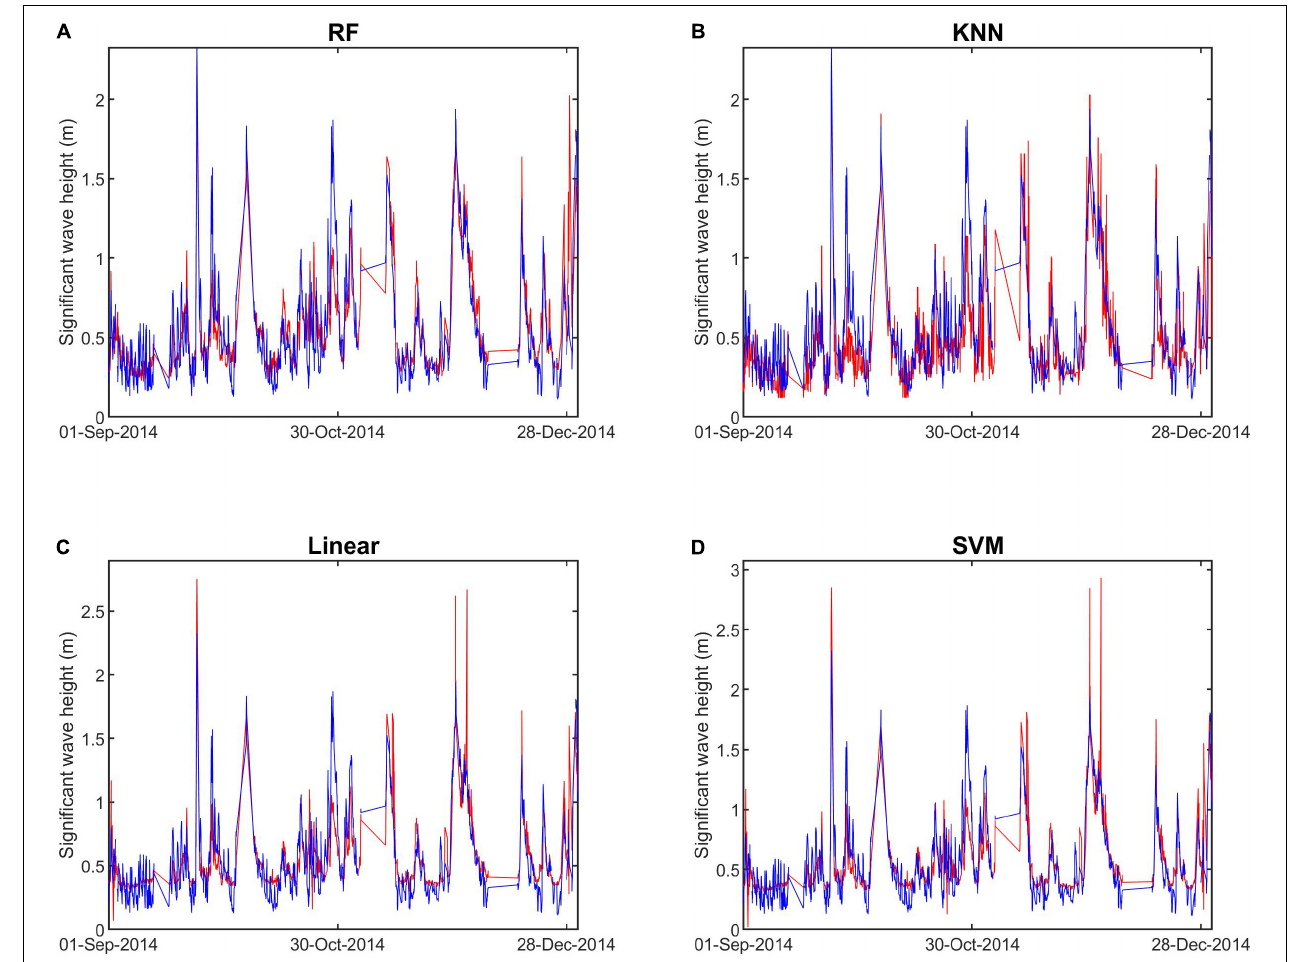
FIGURE 11 | Measured ( blue line ) and predicted ( red line ) significant wave height time series of the Catania buoy from 1 September to 31 December 2014. The prediction was carried out by RF regression (A) , KNN regression (B) , linear regression (C) , and SVM regression (D)